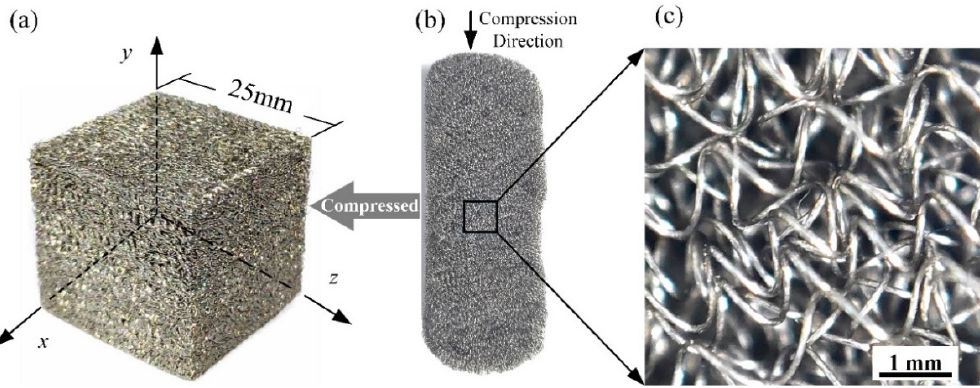
Figure 1. The forming process of MR: ( a ) MR cube with 25-mm sides, ( b ) workblank of the MR cube, ( c ) micro springs of the workblank.